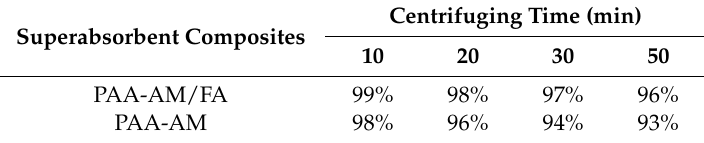
Table 2. The water retention of PAA-AM/FA composite and PAA-AM under pressure of 4000 rpm (wt.